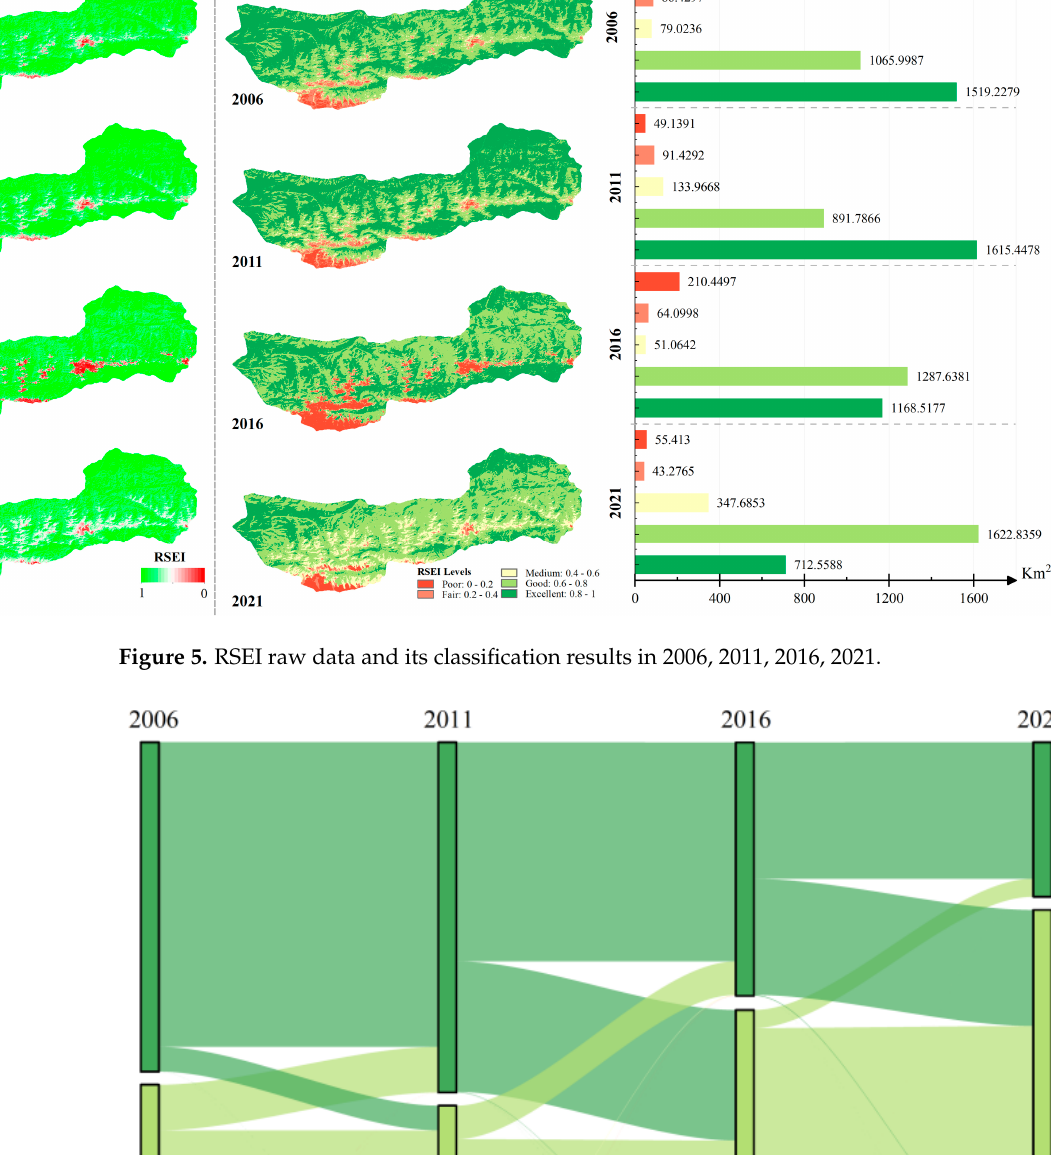
8 of 21 Figure 4. ( a ) Four factors and (b) RSEI statistics for 2006–2021. 3.2. Spatiotemporal Ecological Environment Changes To further analyze the spatial distribution of the EE in the Kalajun–Kuerdening WNHS, the RSEI in the study site was divided into fi ve classes [21,27,34,49]. Each level was in increments of 0.2, poor (level 1): 0 < RSEI ≤ 0.2; fair (level 2): 0.2 < RSEI ≤ 0.4; medium (level 3): 0.4 < RSEI ≤ 0.6; good (level 4): 0.6 < RSEI ≤ 0.8; excellent (level 5): 0.8 < RSEI ≤ 1.0. The results show (Figure 5b) that the spatial area with a poor EE (RSEI ≤ 0.4) in the heritage site from 2006 to 2021 is located in the southwest region, which is covered with glacial snow all year round and is not favorable to the growth of ecological vegetation under very cold temperatures. The areas with a good EE (RSEI > 0.6) are in the northwest